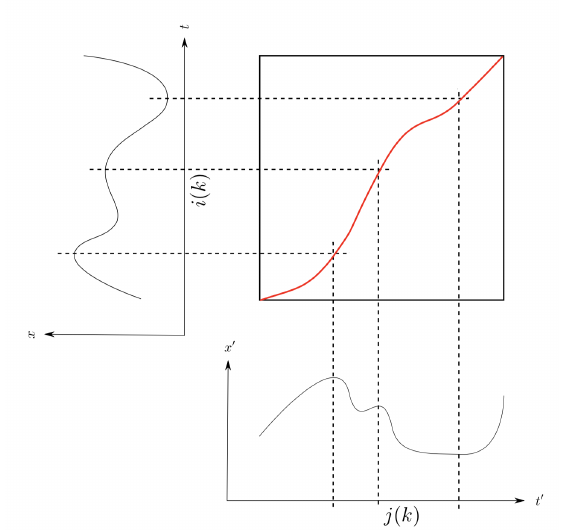
Figure 2. Two time series alignment: on the left the original signal u , at the bottom the signal v to be rematched, in the middle the realignment path P of between the two